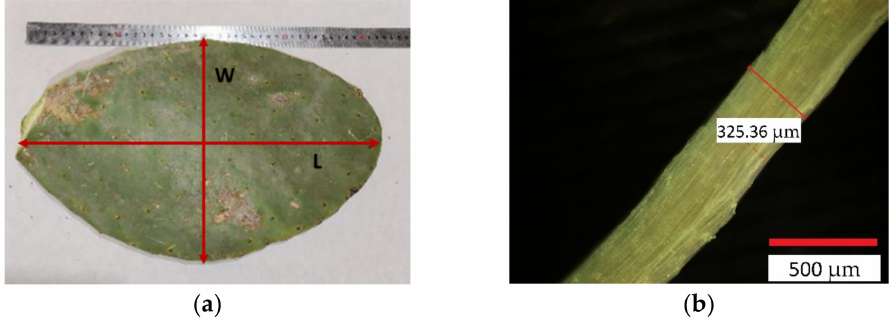
Figure 3. ( a ) Biometric parameters measured in the OM cladodes. L: length; W: width. ( b ) Fibre bundle width measured by an optical